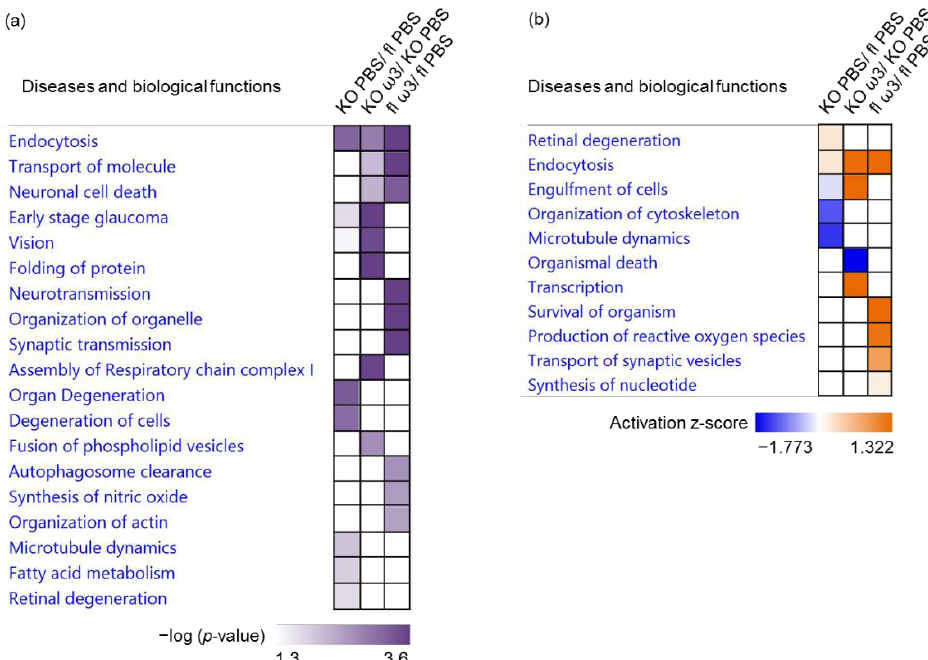
Figure 6. Top significantly affected diseases and biological functions in the retina. The clustering of the most significantly affected diseases and biological functions in the retina depicted according to the ( a ) −log10 ( p- value) and ( b ) activation z-score. Overall z-scores are represented by the colour orange, which indicates activation, and blue indicates inhibition of the signalling pathways.